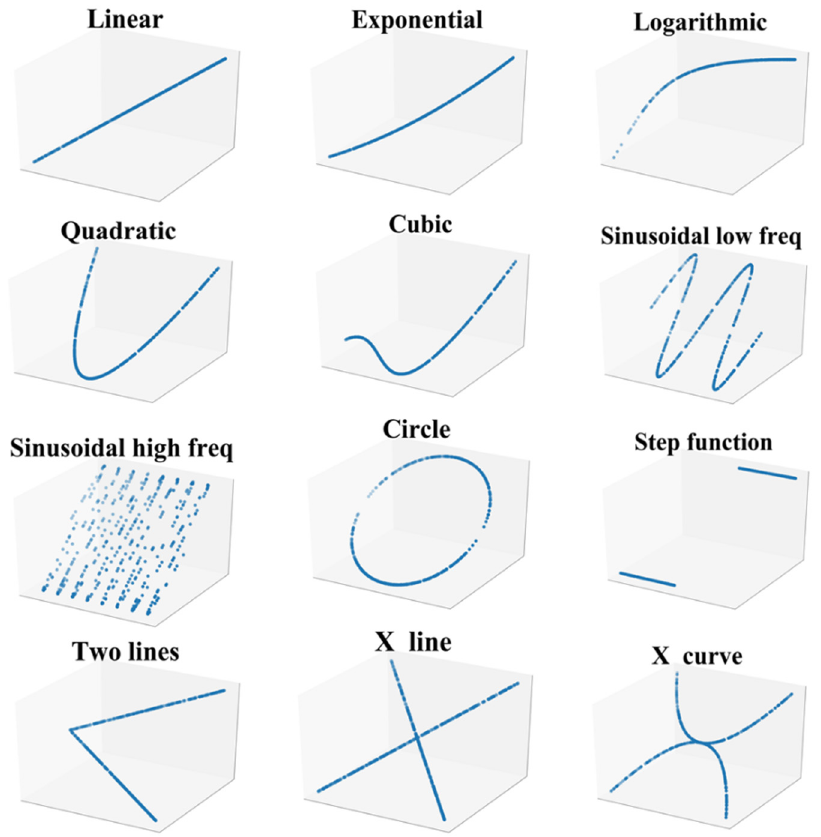
Figure 6. 12 functional relationships used to verify generality. Table 3. Generality performance of MTDIC, QOTIC, and